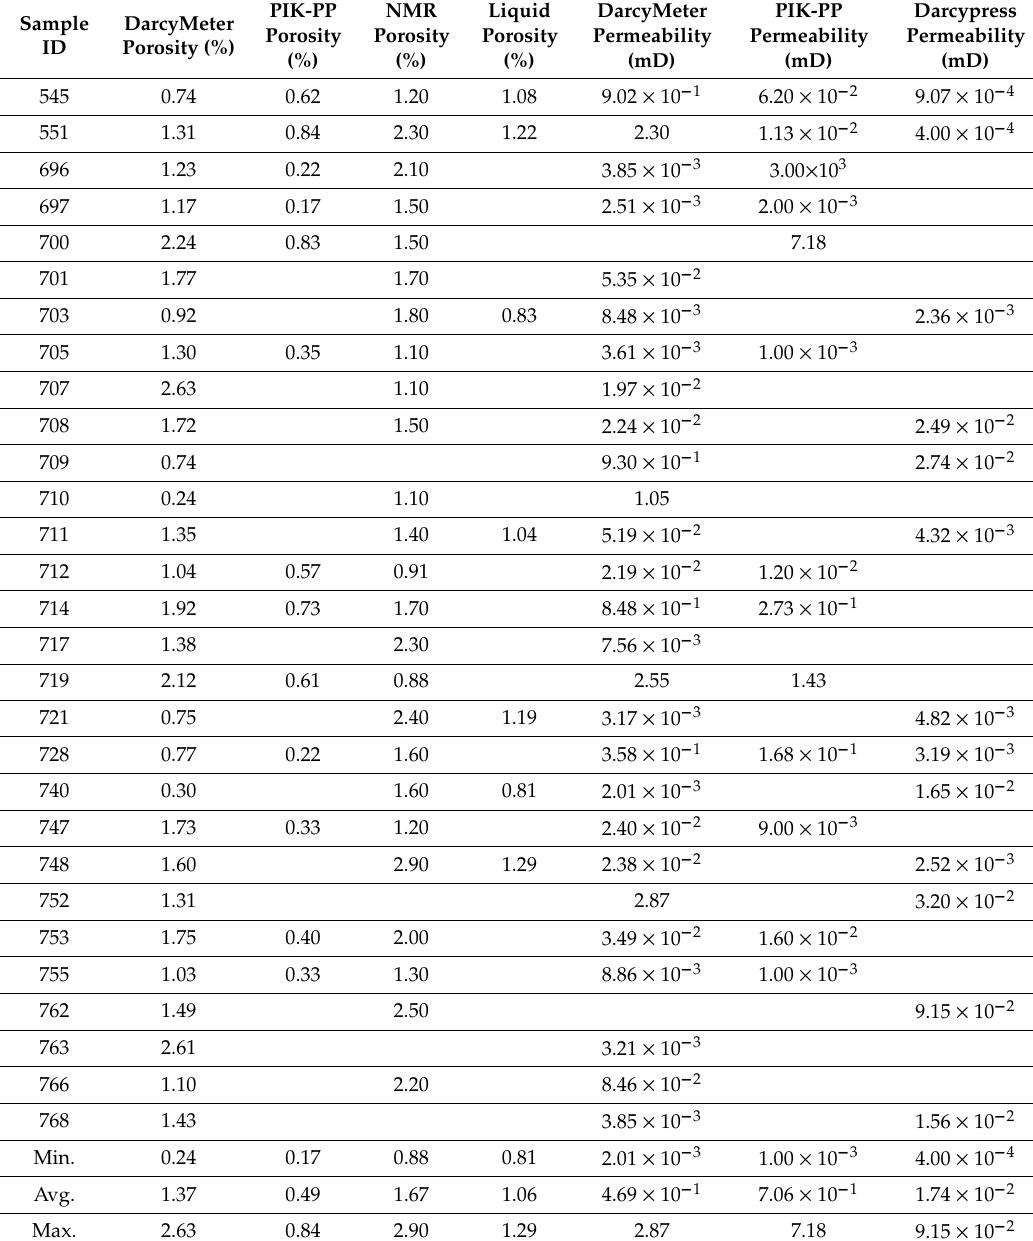
Table 2. Porosity and permeability of the core plugs (including a priori Darcymeter data) and core